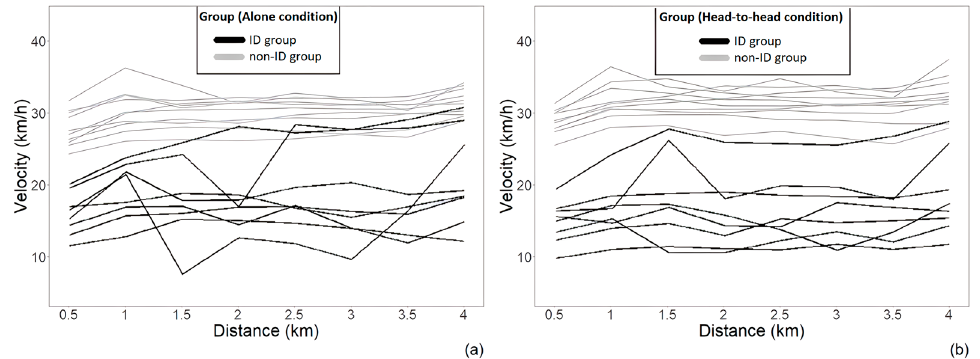
Figure 1. Individual pacing strategies of the ID and non-ID group at the ‘alone’ condition ( a ) and the ‘head-to-head’ condition ( b ).